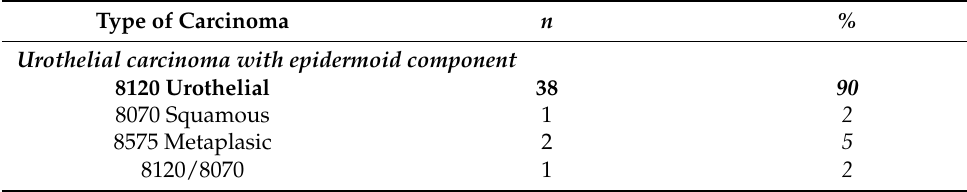
Figure 1. Participation of cancer registries (CRs) by country. Table 1. Morphology coding practices for composite